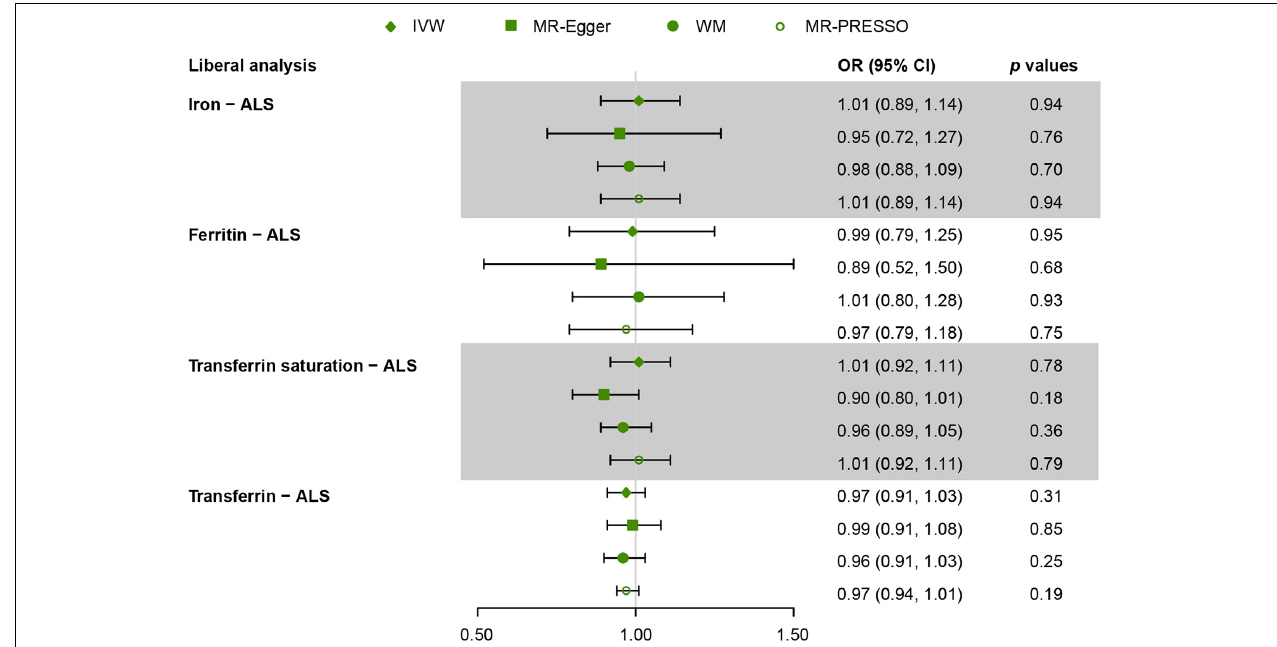
FIGURE 3 | Mendelian randomization (MR) estimates for each of the four biomarkers of iron status in liberal analyses. OR, odds ratio; CI, confidence interval; ALS, amyotrophic lateral sclerosis; IVW, inverse variance weighted; MR-Egger, Mendelian randomization Egger regression method; WM, weighted median; MR-PRESSO, Mendelian randomization pleiotropy residual sum and